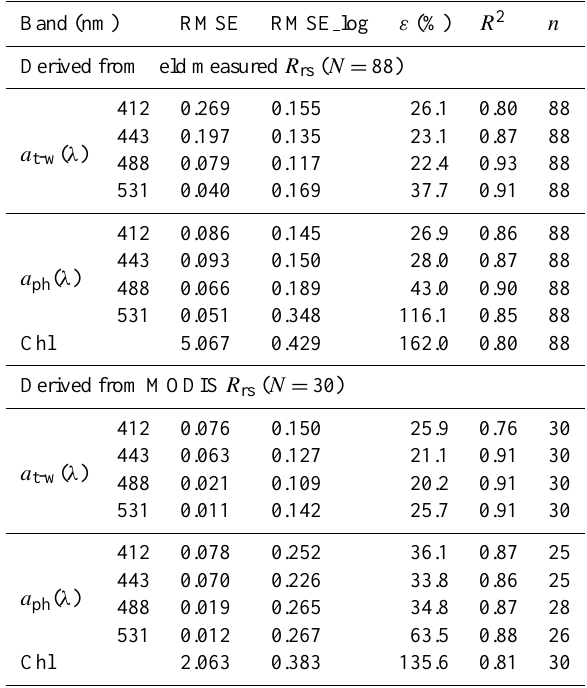
Table 2. Statistics results between derived and in situ absorption coefficients and Chl data ∗